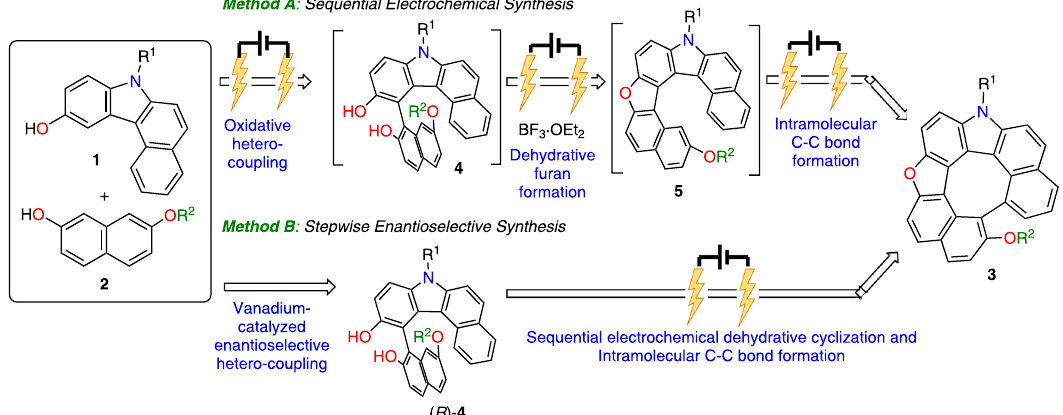
Fig. 1 Sequential electrochemical synthesis of aza-oxa-dehydro[7]helicenes (this work). Two methods for synthesizing dehydro[7]helicenes 3 : ( A ) electrochemical sequential synthesis through the oxidative hetero-coupling of 1 and 2 followed by dehydrative cyclization and intramolecular C-C bond formation; ( B ) stepwise enantioselective synthesis through chiral vanadium-catalyzed hetero-coupling and electrochemical oxidative